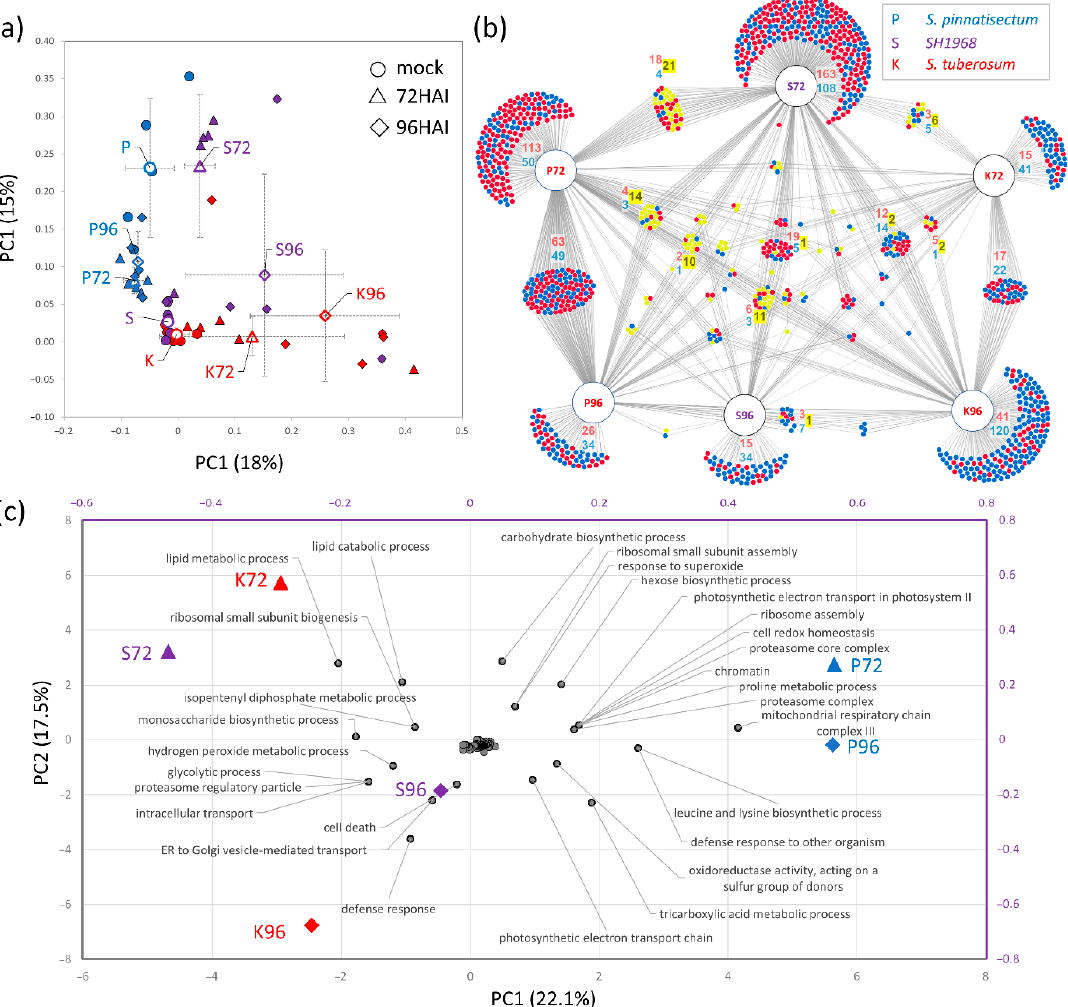
Figure 2. Genotype ‐ specific response to Phytophthora inoculation. ( a ) Separation of proteome profiles based on relative abundances of differentially abundant proteins including the means and standard deviations. ( b ) The overlap in identified differentially abundant proteins (compared to the mock) was visualized by DiVenn [26]. Red and blue dots represent significant increases and decreases in protein abundances, respectively. Yellow dots indicate the number of proteins with a contrasting response in different genotypes and/or time points. Only proteins with at least two unique peptides were evaluated. ( c ) Comparison of enriched GO categories in the sets of differentially abundant proteins. For the sake of clarity, categories with at least five proteins were included in the final analysis, and only filtered GO terms with the most significant contribution to the separation in PC1 or PC2 are labeled. K, S. tuberosum cv. Kerkovsky rohlicek; P, S. pinnatisectum ; S, hybrid SH1968. For details, see Supplementary Materials Tables